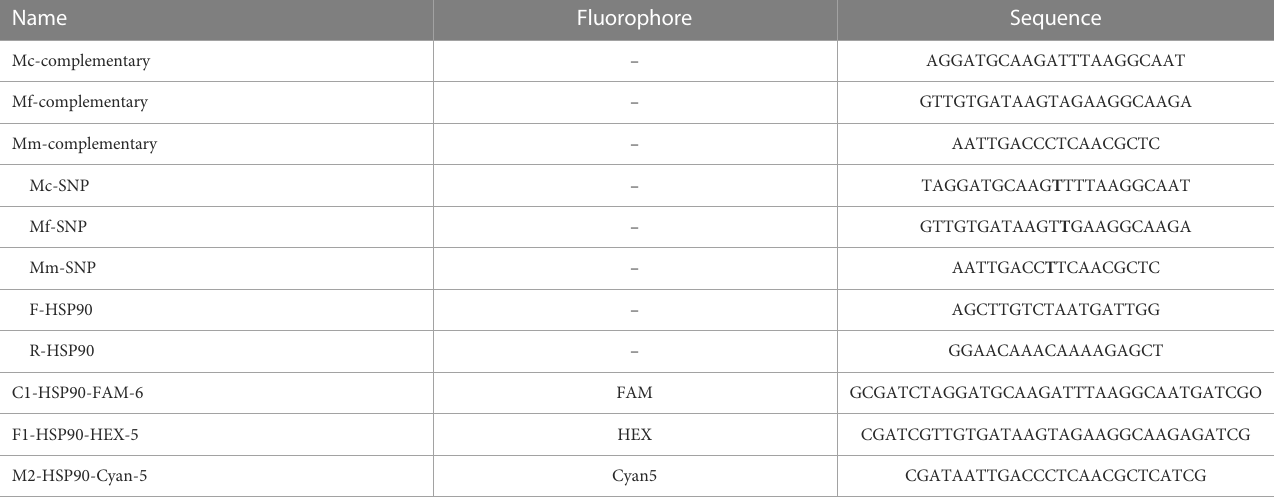
TABLE 2 Primers and beacon probes used in the molecular beacon RT-PCR assays.